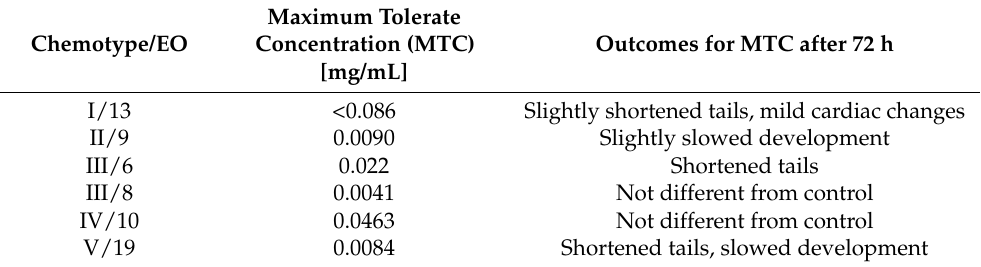
Table 3. Toxicity evaluation for chemotype representatives on zebrafish after 72 h of incubation. For EO numbering, see Table 4. Maximum Tolerate Chemotype/EO Concentration (MTC) Outcomes for MTC after 72 h [mg/mL] I/13 <0.086 Slightly shortened tails, mild cardiac changes II/9